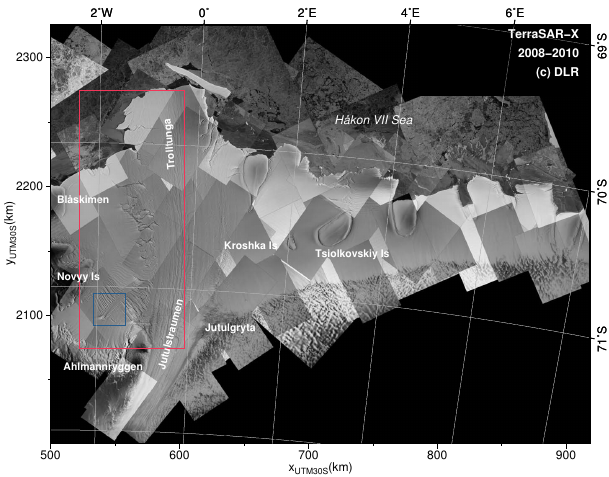
Fig. 1. Map of Fimbulisen showing TerraSAR-X mosaic derived from images in stripmap mode and ScanSAR mode acquired be- tween 2008 and